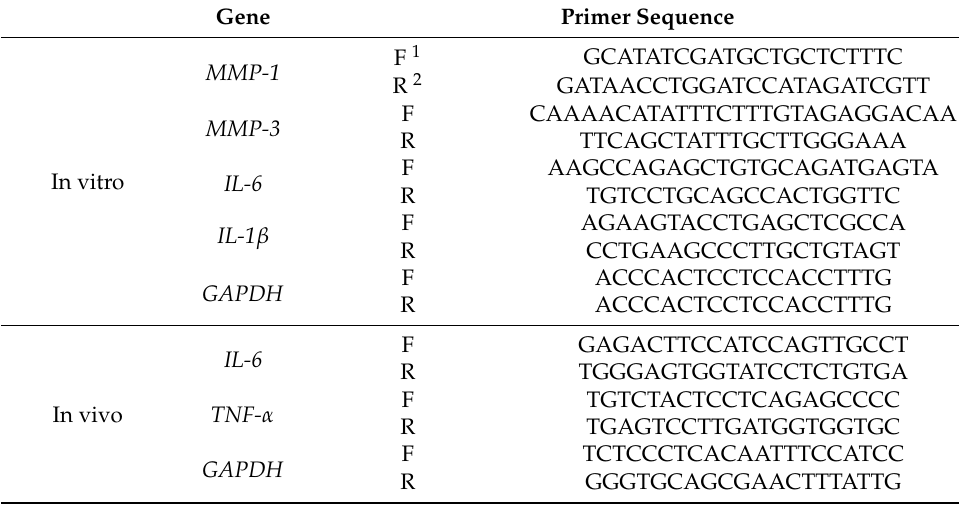
Table 1. Primer sequences for qRT-PCR